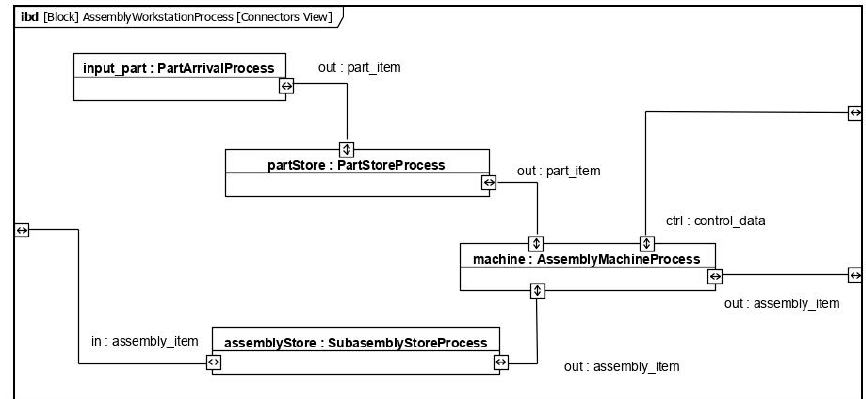
Figure 4. Internal block diagram of the WorkstationProcess block.